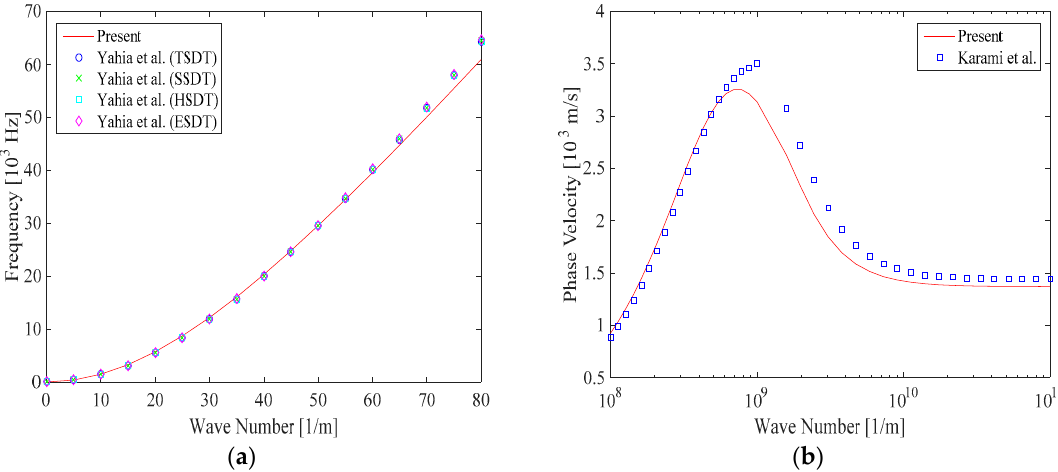
Figure 3. Comparison of wave frequency in rectangular plate ( a ) and phase velocity in P-FGM nanoplates ( b ) vs. the wave number. ( l = 0.2, µ 0 = µ 1 = µ = 1, n = 1, ξ = 0.2 ) .